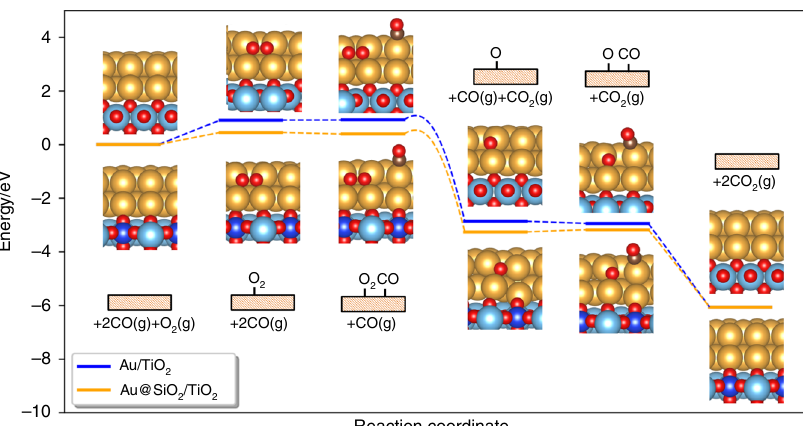
Fig. 6 Calculated reaction mechanism of CO oxidation on Au/TiO 2 and Au@SiO 2 /TiO 2 . The structures with only adsorbed species are shown in the inserted fi gures and the gaseous species are ignored. The gold, red, cyan, brown, and blue balls are Au, O, Ti, C, and Si